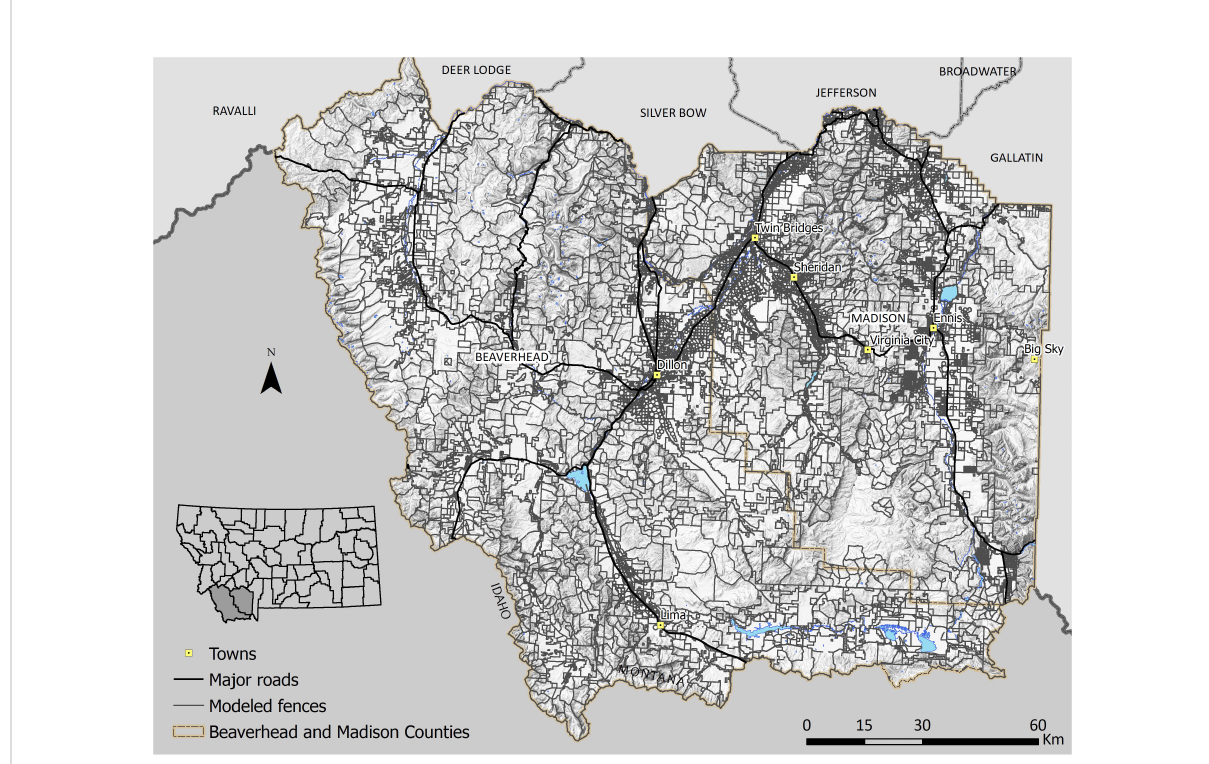
FIGURE 1 Predicted fence locations in Beaverhead and Madison Counties, Montana, using a GIS model of land tenure, roads, and land cover data. The fence model was moderately accurate (K = 0.56) and predicted ~34,700 km of